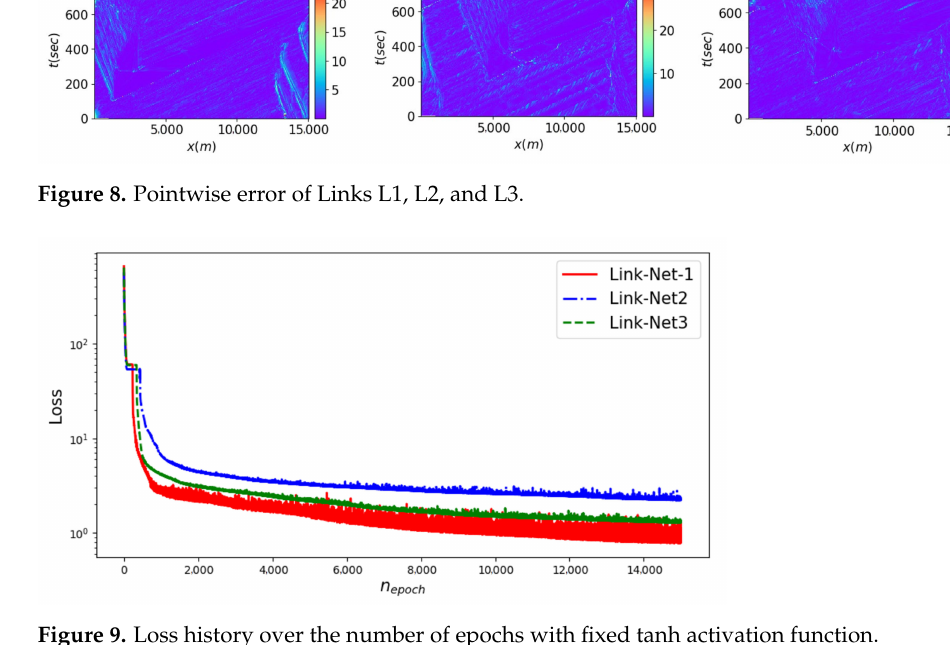
Figure 9. Loss history over the number of epochs with fixed tanh activation function.